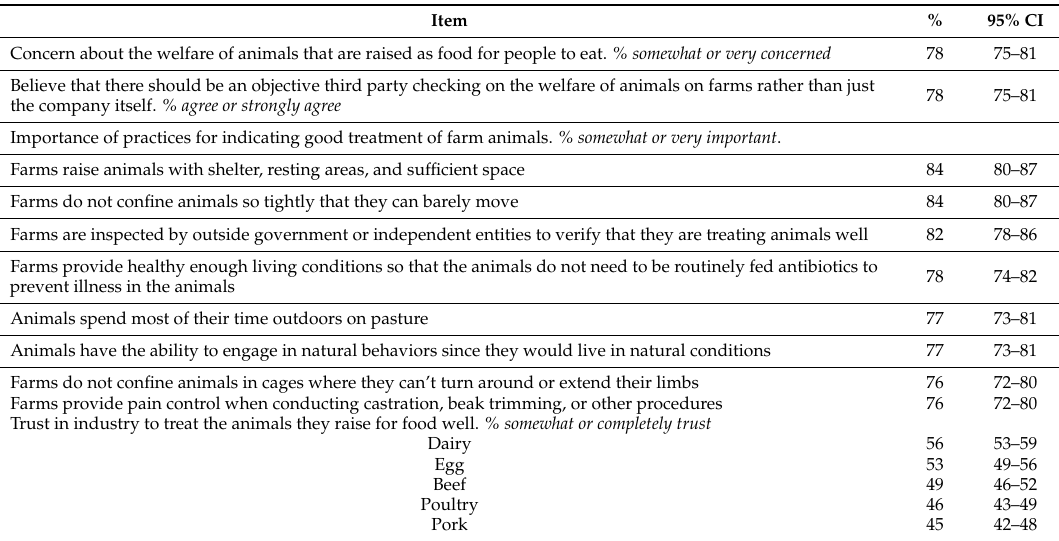
Table 2. Attitudes towards farm conditions and the meat, egg, and dairy industry.